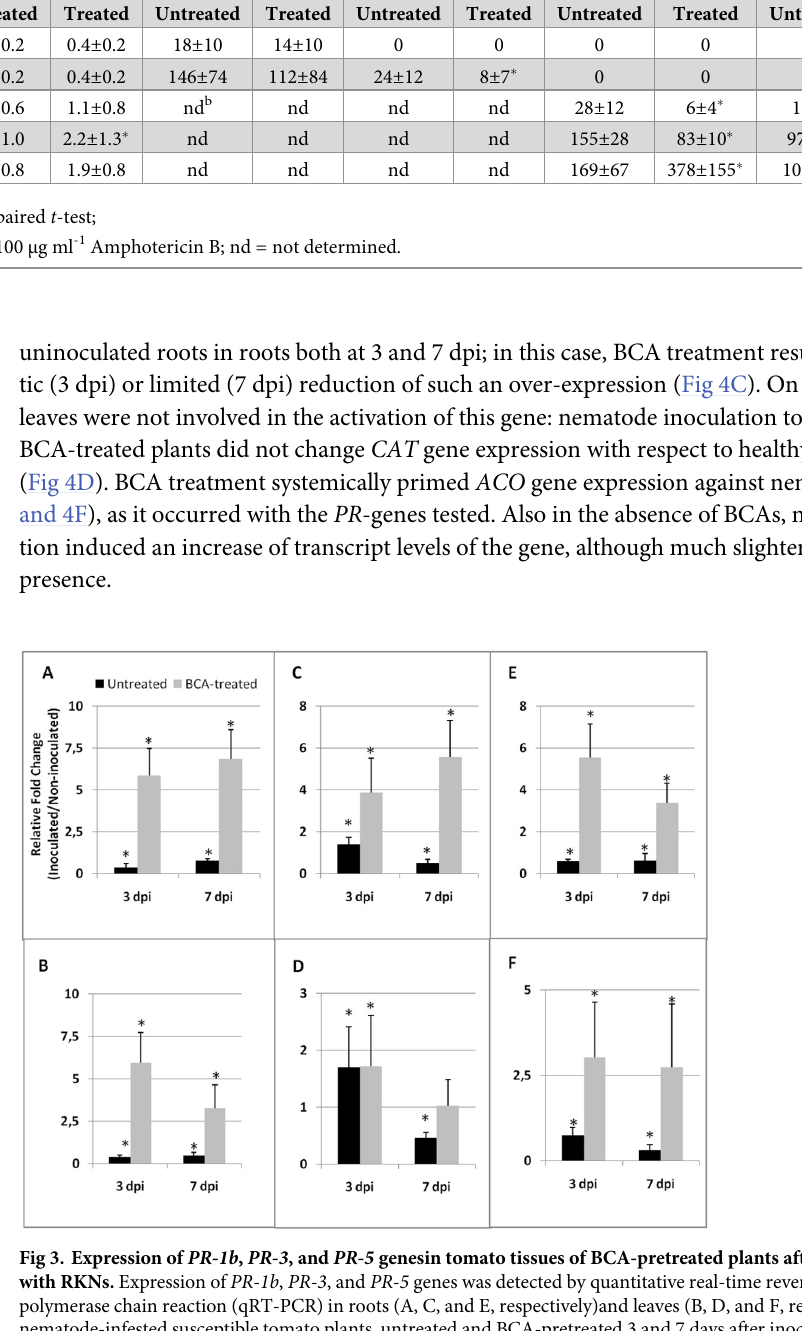
Fig 3. Expression of PR-1b , PR-3 , and PR-5 genesin tomato tissues of BCA-pretreated plants after inoculation with RKNs. Expression of PR-1b , PR-3 , and PR-5 genes was detected by quantitative real-time reverse-transcription polymerase chain reaction (qRT-PCR) in roots (A, C, and E, respectively)and leaves (B, D, and F, respectively)of nematode-infested susceptible tomato plants, untreated and BCA-pretreated,3 and 7 days after inoculation (dpi) with 300 J2 M . incognita . Data are the mean fold changes (n = 6) ± SD in gene transcript levels of tissues from inoculated plants compared with tissues from non-inoculated control plants (the value of 1 indicates no change). An asterisk ( � ) indicates that the mean fold change is significantly different from 1 as determined by the non-parametric Kolmogorov- Smirnov test (P <